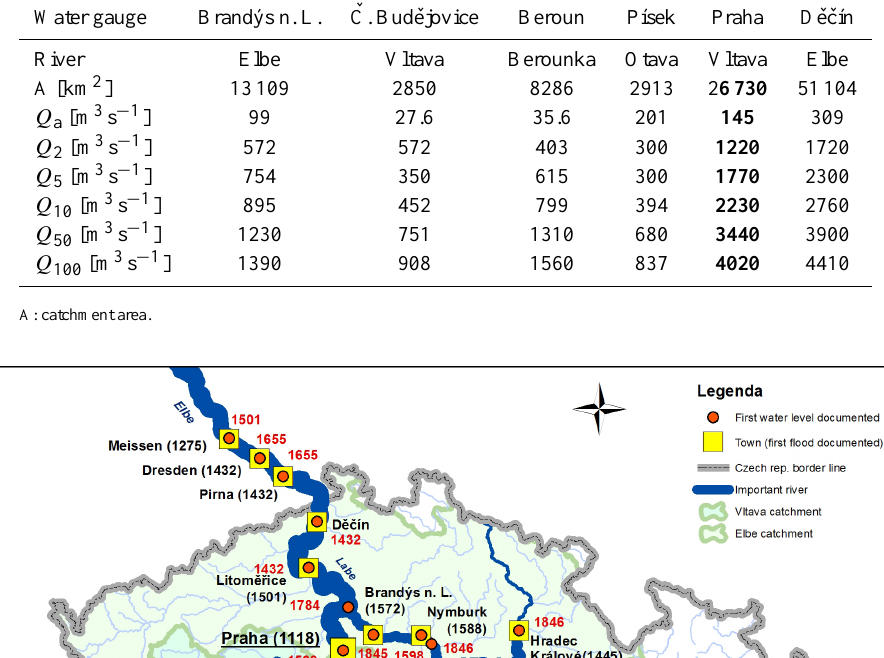
essential for the examination of historical floods.